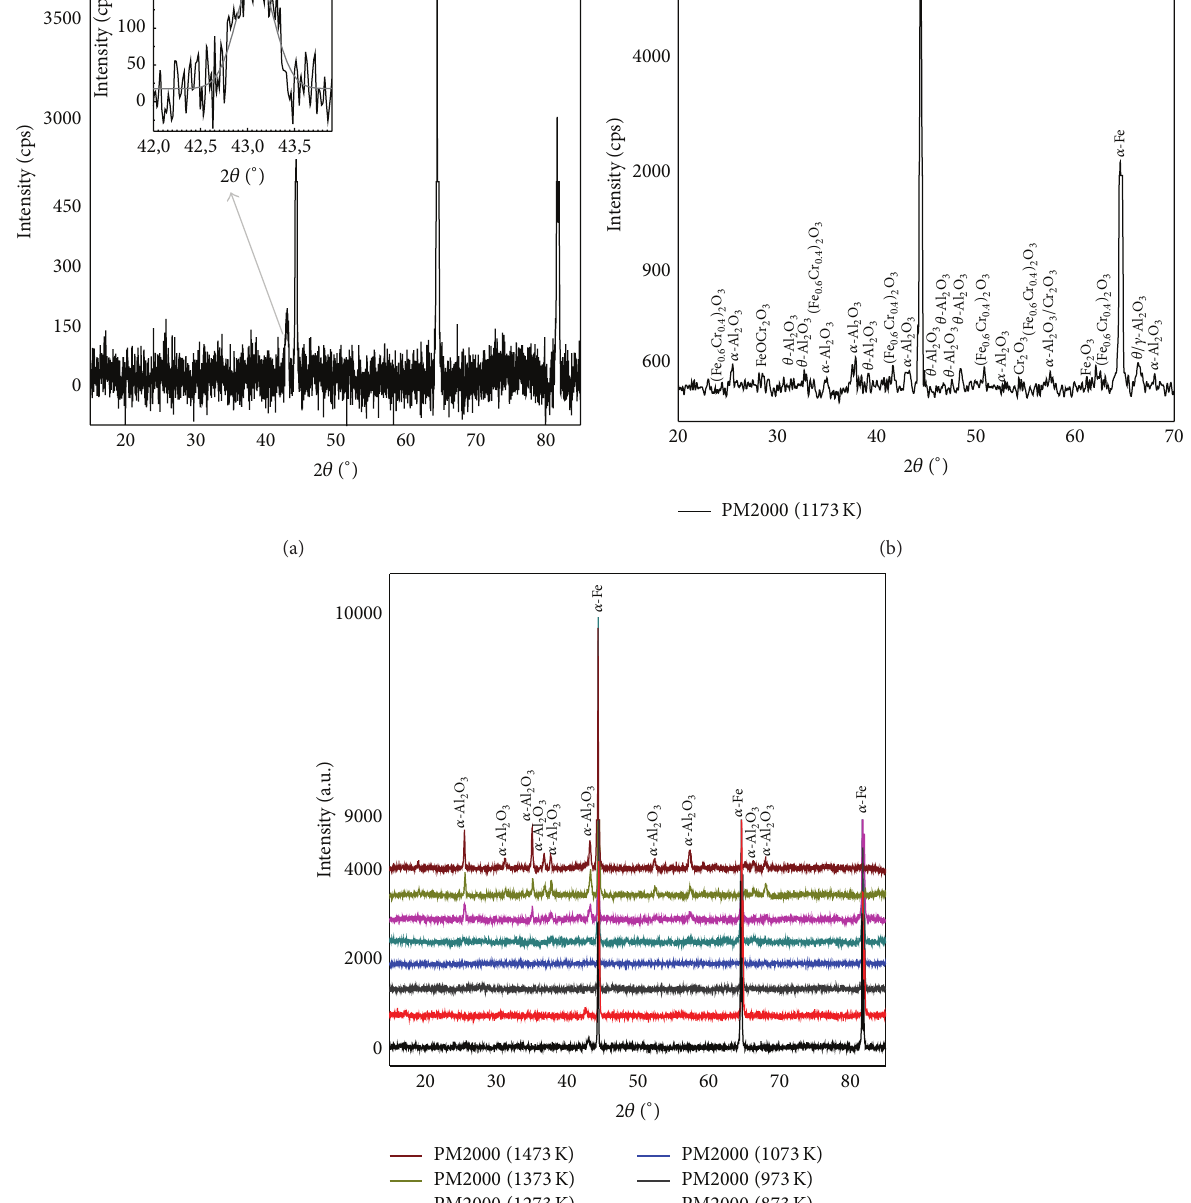
extending band in the range 400–700 cm −1 indicates the existence of amorphous structure or disordered defects). The FTIR spectrum obtained after oxidation in air for 7 h of a PM2000 sample at 1073 K (Figure 6(b)) differs from the previous one. Peaks appear, indicating the presence of a better crystallized phase; the presence of 𝛼 -Al 2 O 3 is also detected in this spectrum. The main peaks at 459, 595, and 656 cm